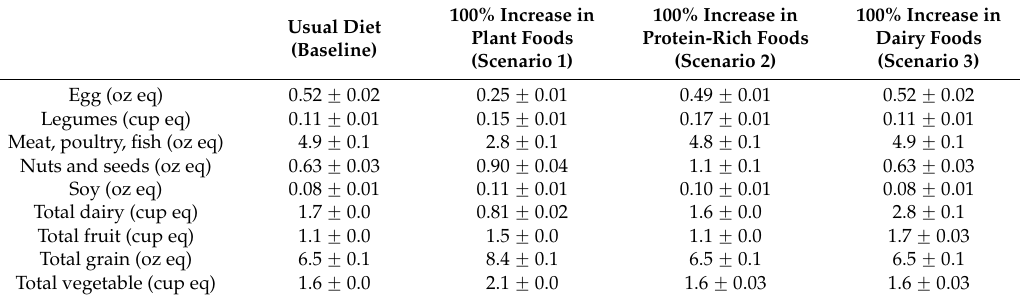
Table 2. Usual food group intake in adults, 19+ years (NHANES 2007–2010) compared to a 100% increase in plant foods, 100% increase in protein-rich plant foods, and 100% increase in dairy foods 1,2